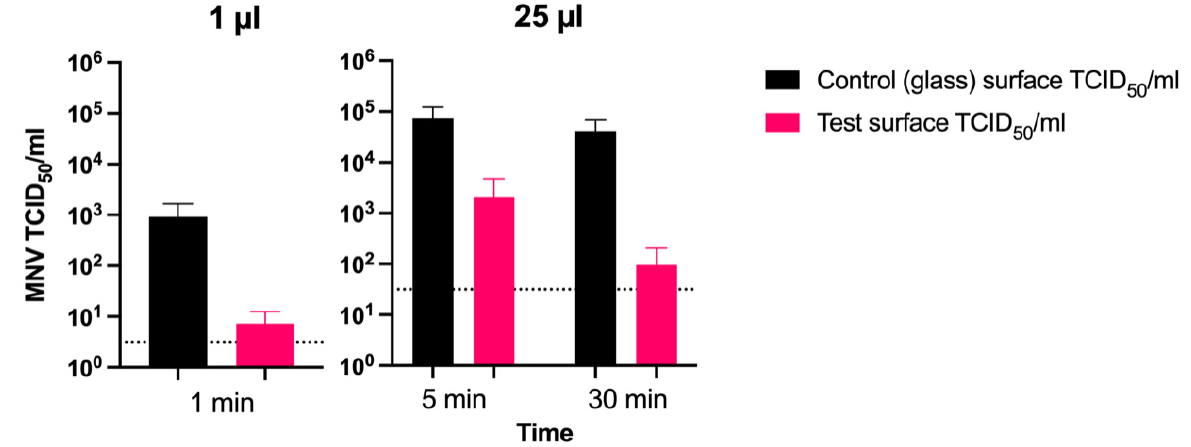
Figure 8. Median tissue culture infectious dose (TCID 50 ) values of MNV dilutions after the surface exposure to the Cu–Ag nanocomposite surface (sample C) compared with that to the negative control glass. MNV showed log 10 reductions of 2.10 ( ± 0.27), 1.69 ( ± 0.40), and 2.72 ( ± 0.40) after 1, 5, and 30 min, respectively, in comparison with on the glass surface. Dashed lines indicate limits of detection.